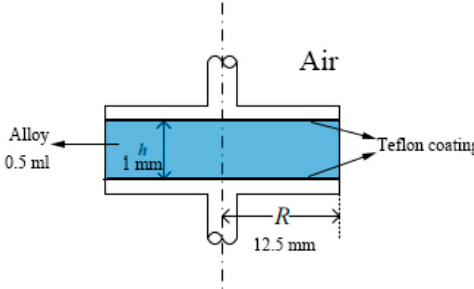
Figure 2. Test parallel plates.